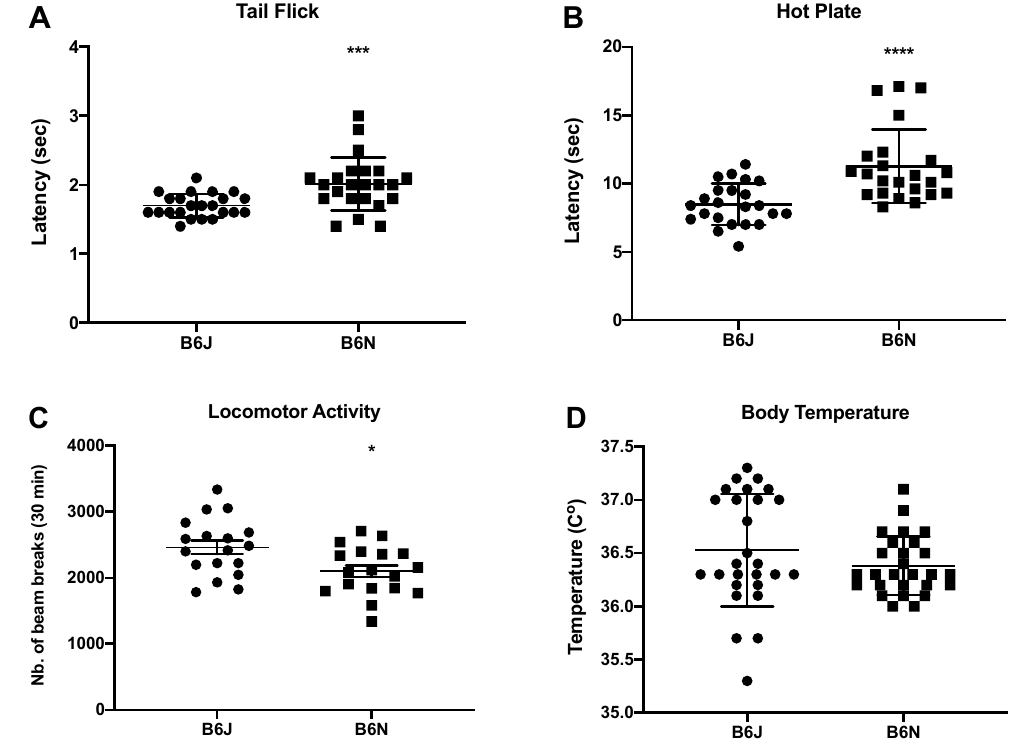
Figure 5. Basal responses for the B6J and B6N substrains. Basal thermal nociception in the male B6J versus B6N substrains demonstrated by latency (sec) in ( A ) the tail flick and ( B ) the hot plate tests ( n = 23/substrain). ( C ) The basal locomotion response in male B6J and B6N mice ( n = 18/substrain). ( D ) The basal body temperature in male B6J and B6N mouse strains ( n = 27/substrain). All data are shown as the mean ± SE. Each data point is representative of each individual mouse response. Significant differences between substrains are based on an unpaired t-test (* p < 0.05, *** p < 0.001, **** p < 0.0001).